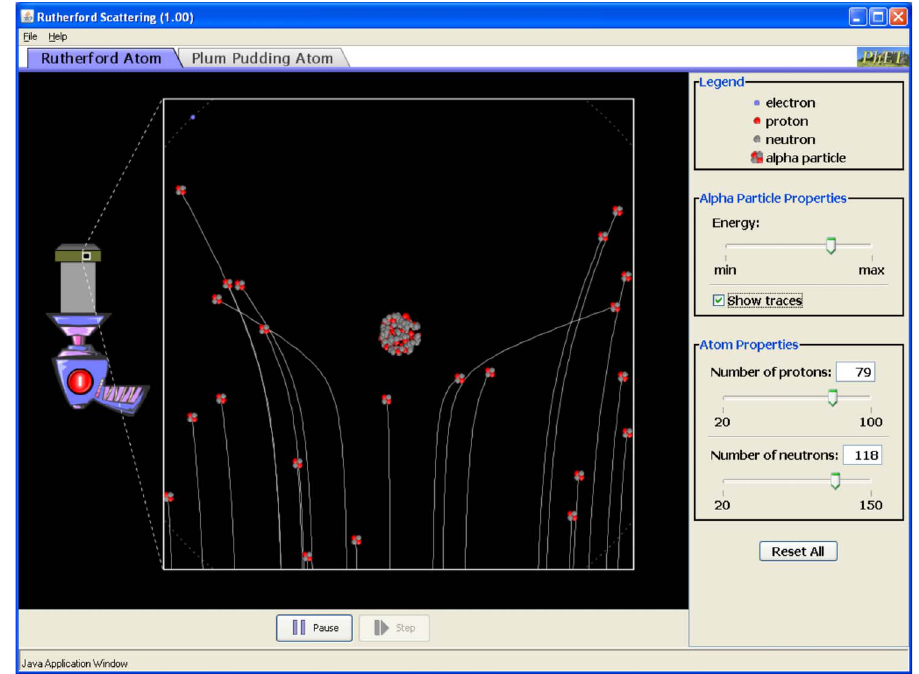
FIG. 9. (cid:1) Color (cid:2) Rutherford scat- tering simulation.